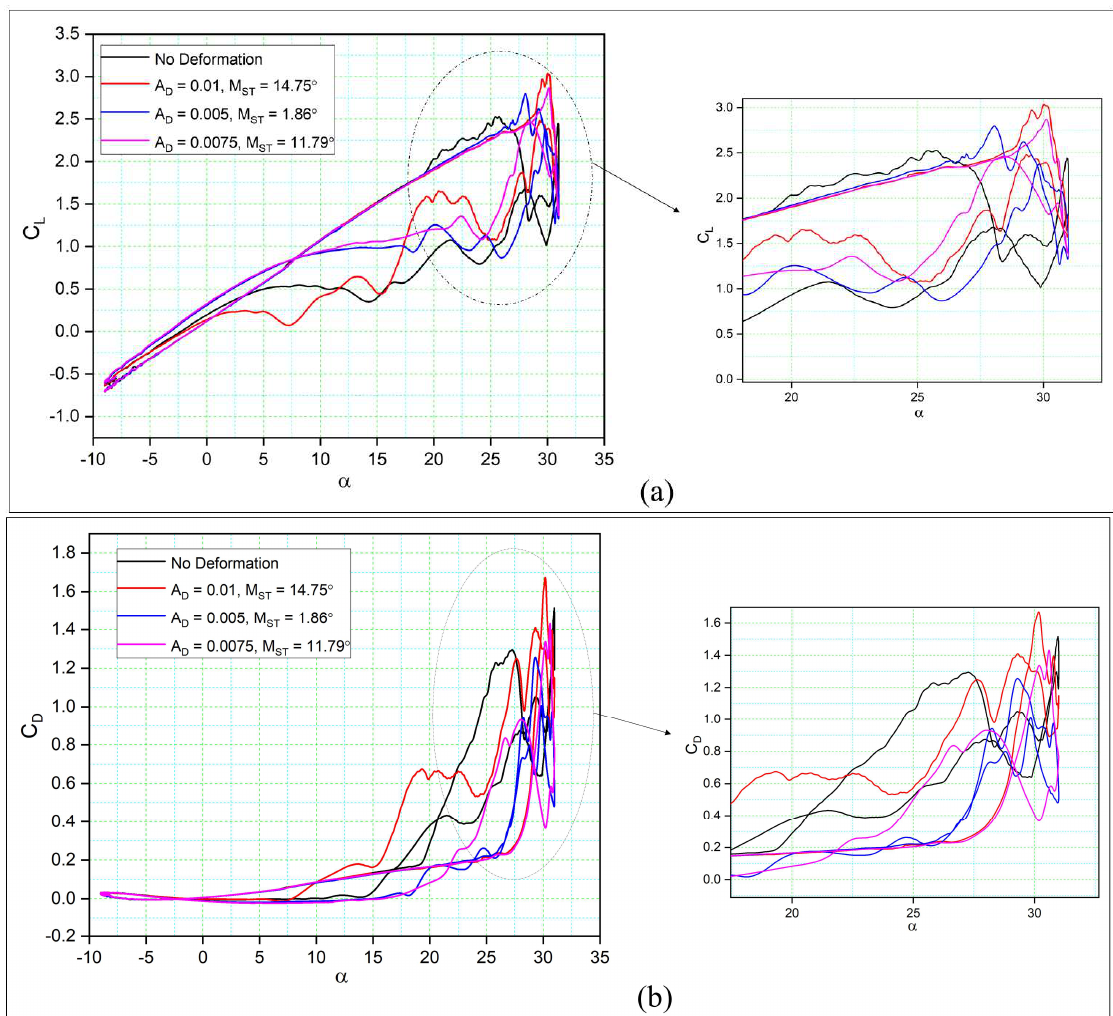
Figure 12. Hysteresis cycles for ( a ) the lift coefficients of DMLE airfoils and ( b ) the drag coefficients of DMLE airfoils compared to the reference